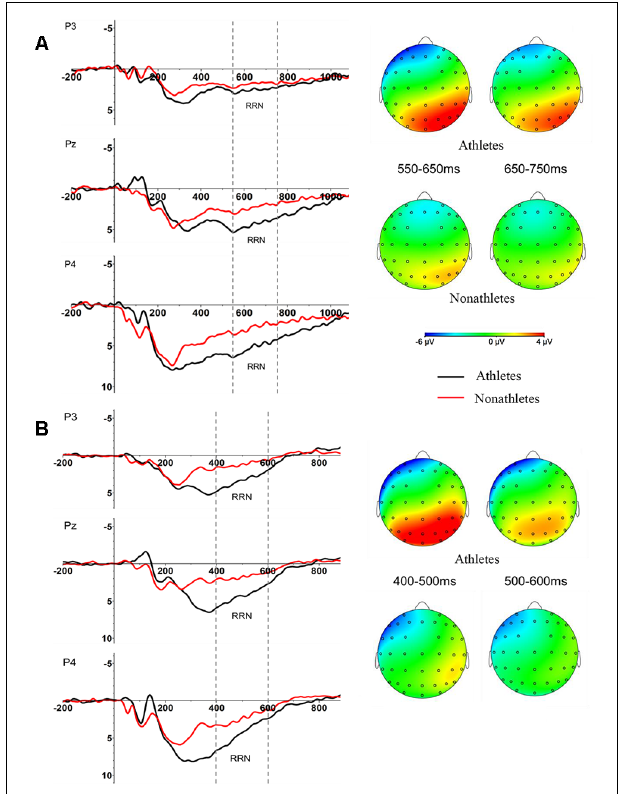
FIGURE 5 | Average amplitude of rotation-related negativity (RRN) at P3, Pz and P4 and spatial distribution over all electrode in OT (A) and ET (B) condition per group (M ± SE).